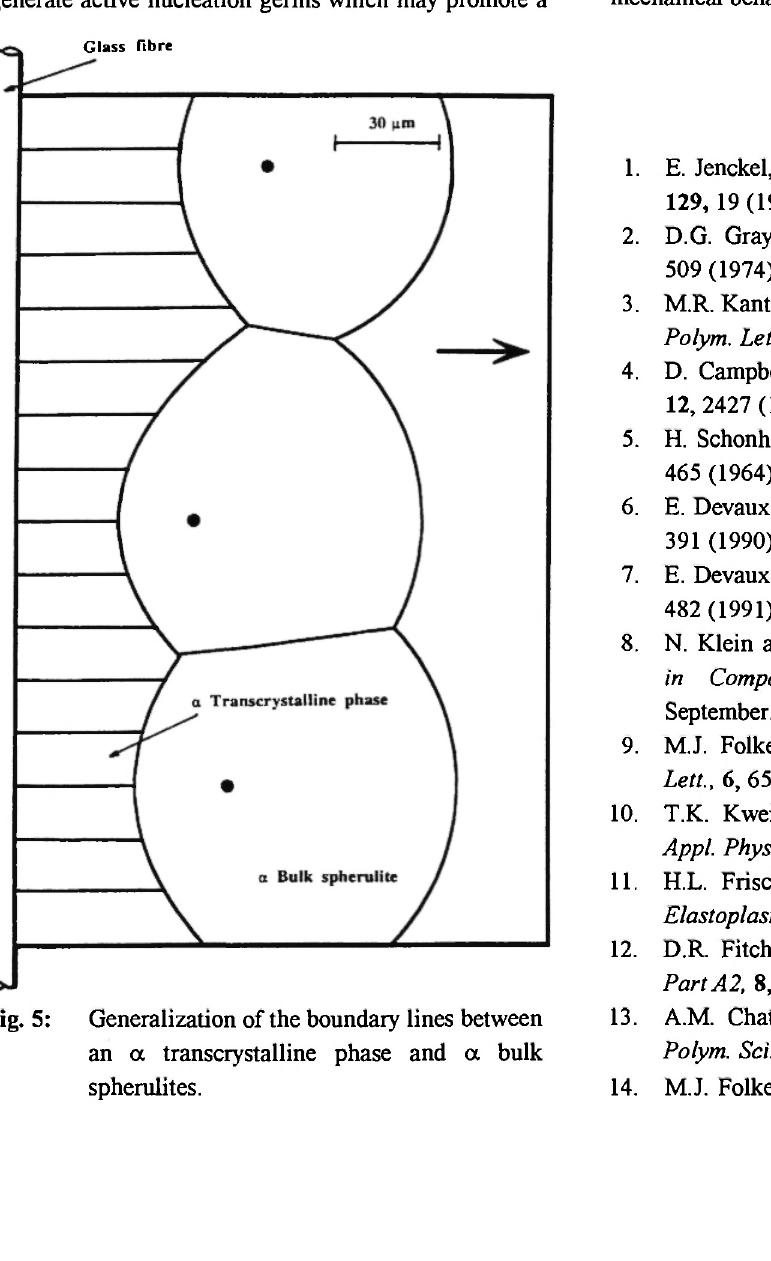
Fig. 5: Generalization of the boundary lines between an α transcrystalline phase and α bulk